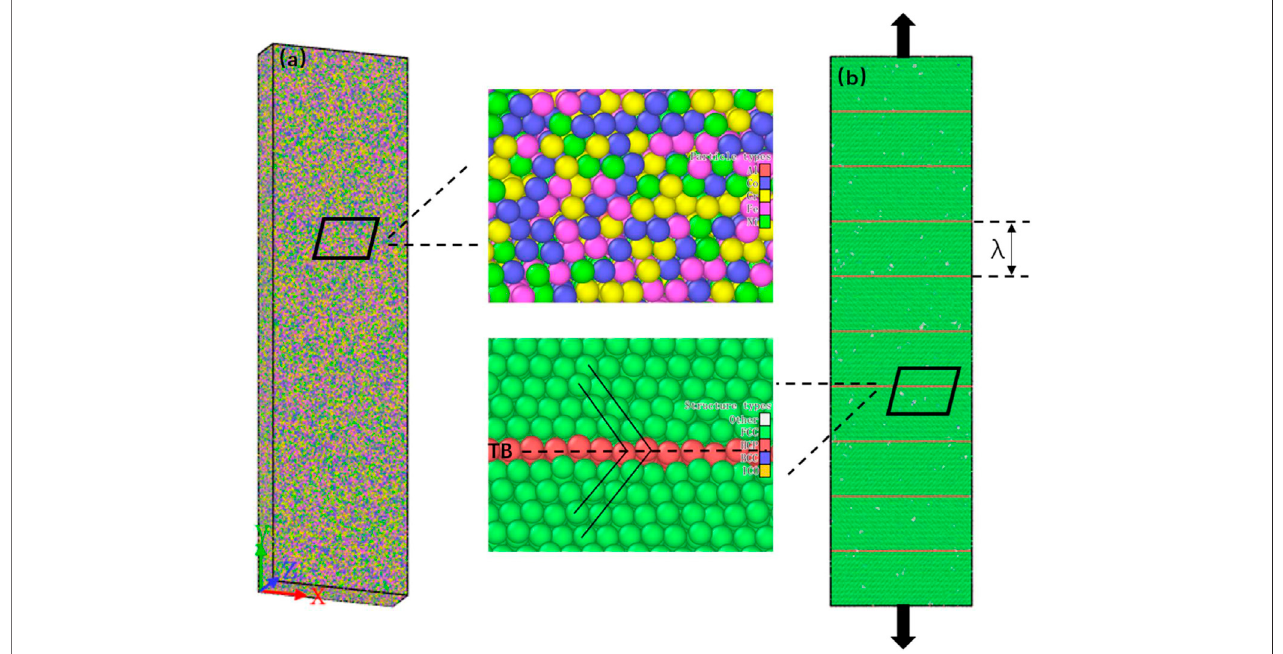
FIGURE1| Modelofthesingle crystallineFCC Al 0.1 CoCrFeNi HEAs. (A) Atomic distribution ofthent-HEAs; (B) modelstructureofthent-HEAs, inwhichthegreen regions represent the FCC structure and the red regions represent the twin boundary (TB).